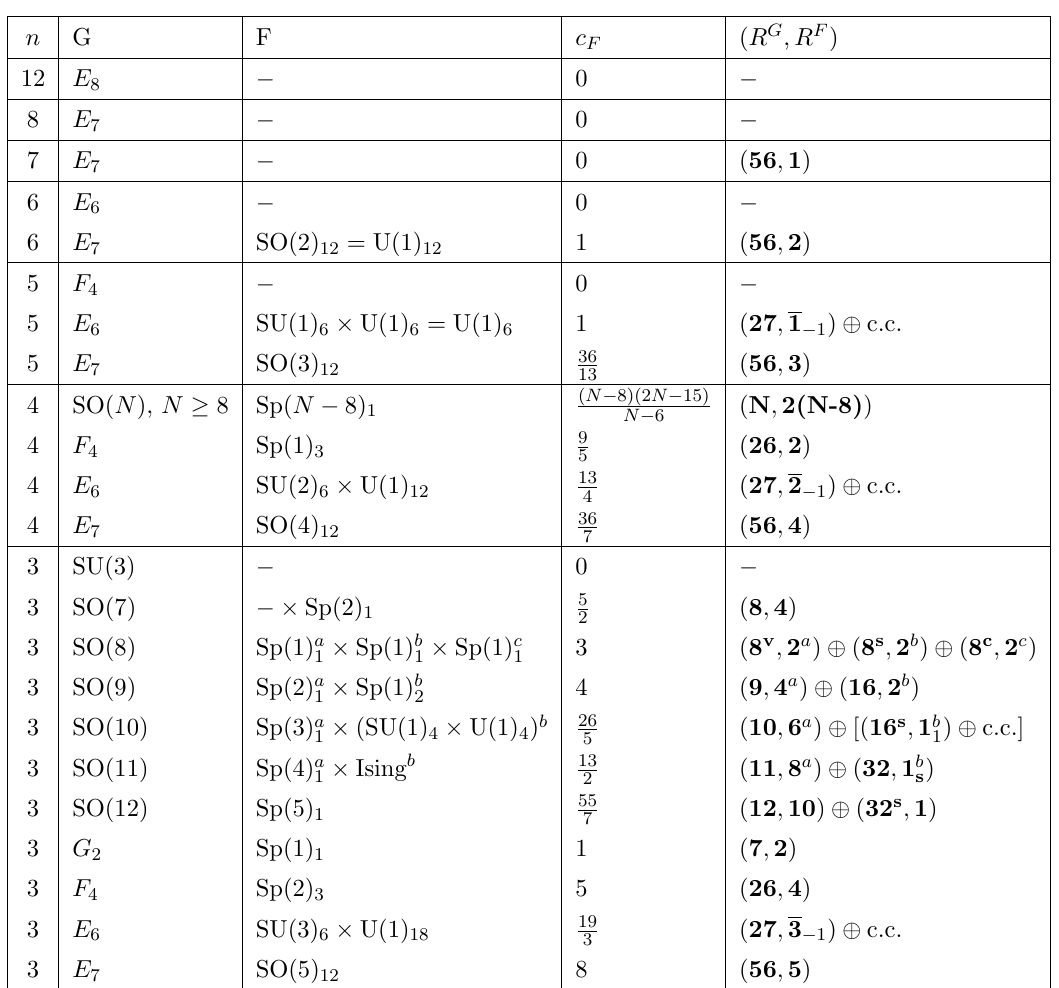
Table 20. Flavor symmetry F of the theories h G for n (cid:21) 3. For each theory, we denote the simple n non-abelian factors in the current algebra by F k , where k is the level. The abelian factors are denoted by U(1) , where R is the radius of the compact boson that realizes the current algebra. R 2 When F includes a product of several non-abelian factors, we use superscripts a; b; : : : to distinguish more easily between them and their representations. The last column displays the representation ( R G ; R F ) of G (cid:2) F in which the matter of the parent 6d SCFT transforms. If F includes a U(1) factor, we indicate the charge with respect to it by a subscript. For the Ising model, 1 s indicates that the Virasoro primary with h = 1 (whose lowest order component is just a single 16